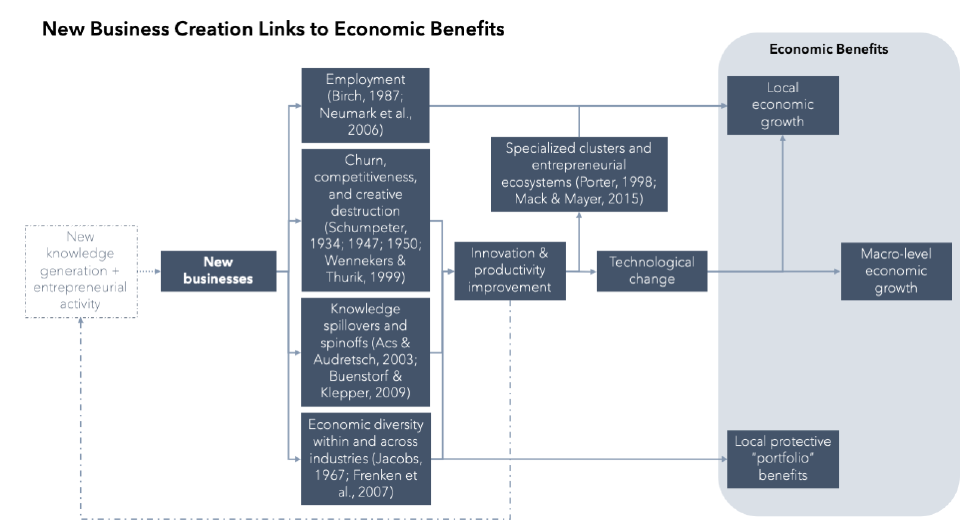
Figure 2: Diagram showing the theoretical connections between new business creation and economic benefits at both the local and macro